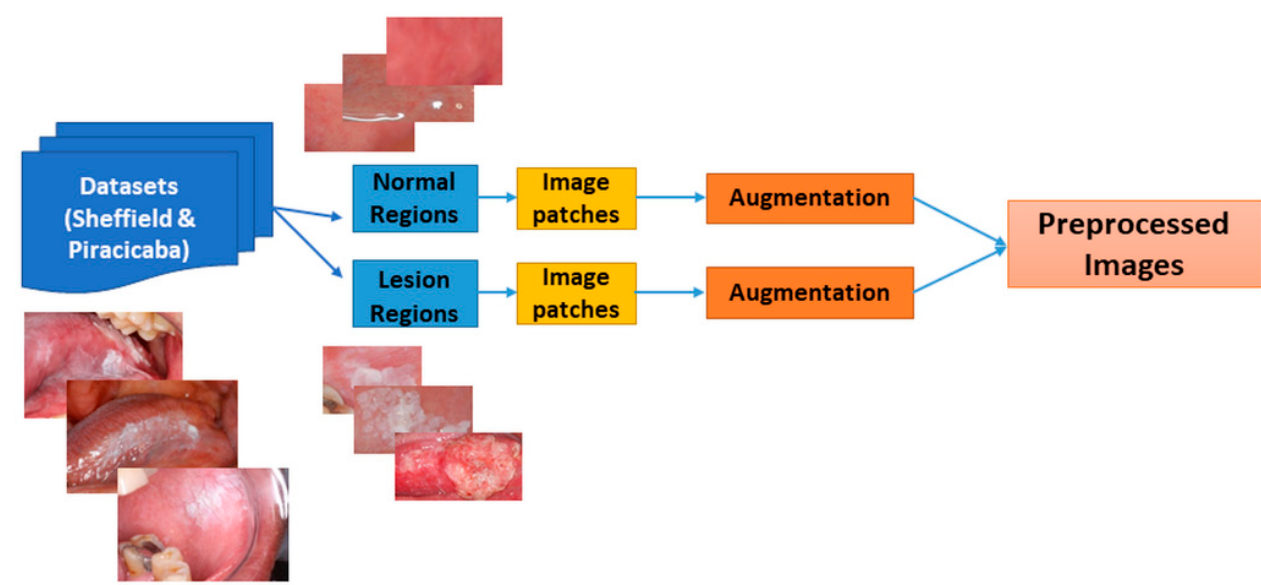
Figure 3. Block diagram of image preprocessing. Two dataset annotated images are cropped from the bounding box of the suspicious and normal regions. Then each image is divided into 128 × 128 image patches. Lastly, the patched images are augmented.